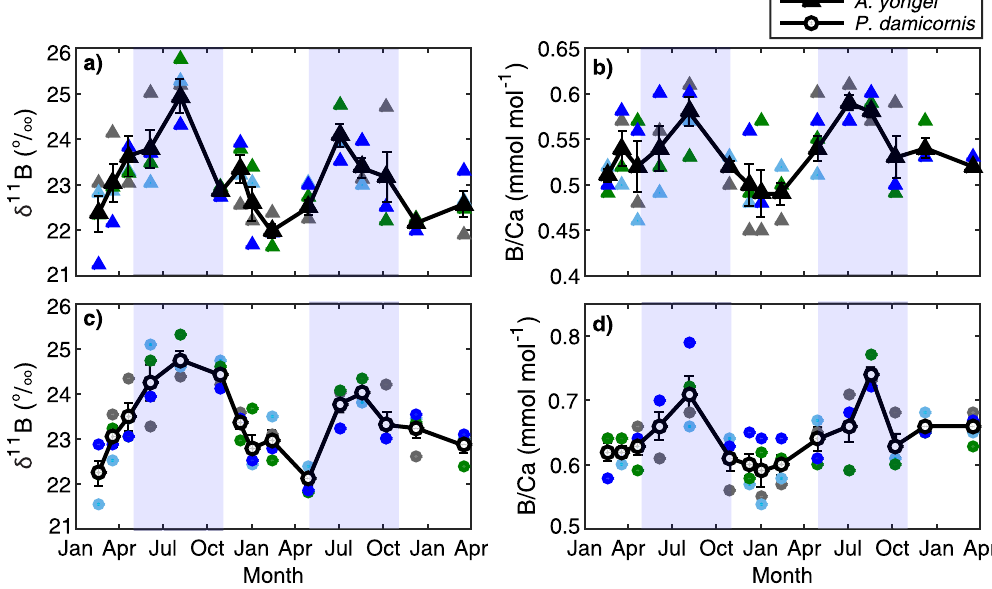
Figure 2. Seasonal changes in the boron isotopic signature and boron to calcium ratio (B/Ca) of corals at Rottnest Island. ( a,b ) Seasonal time-series of δ 11 B (‰) and ( c,d ) boron to calcium ratios (B/Ca) for all four colonies sampled of Acropora yongei and Pocillopora damicornis . Coloured symbols represent each colony while the black symbols with lines denote the mean ± 1 SE ( n = 4) for each time point. Light blue shading denotes winter and unshaded areas denote summer, defined based on seasonal changes in temperature and